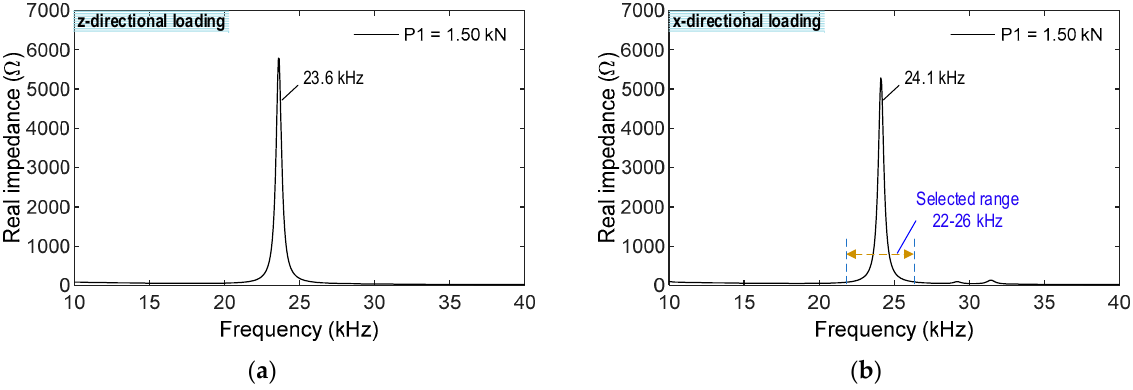
Figure 8. CSA’s impedance signals in frequency range of 10–40 kHz for intact case. ( a ) z-directional loading. ( b ) x-directional loading.